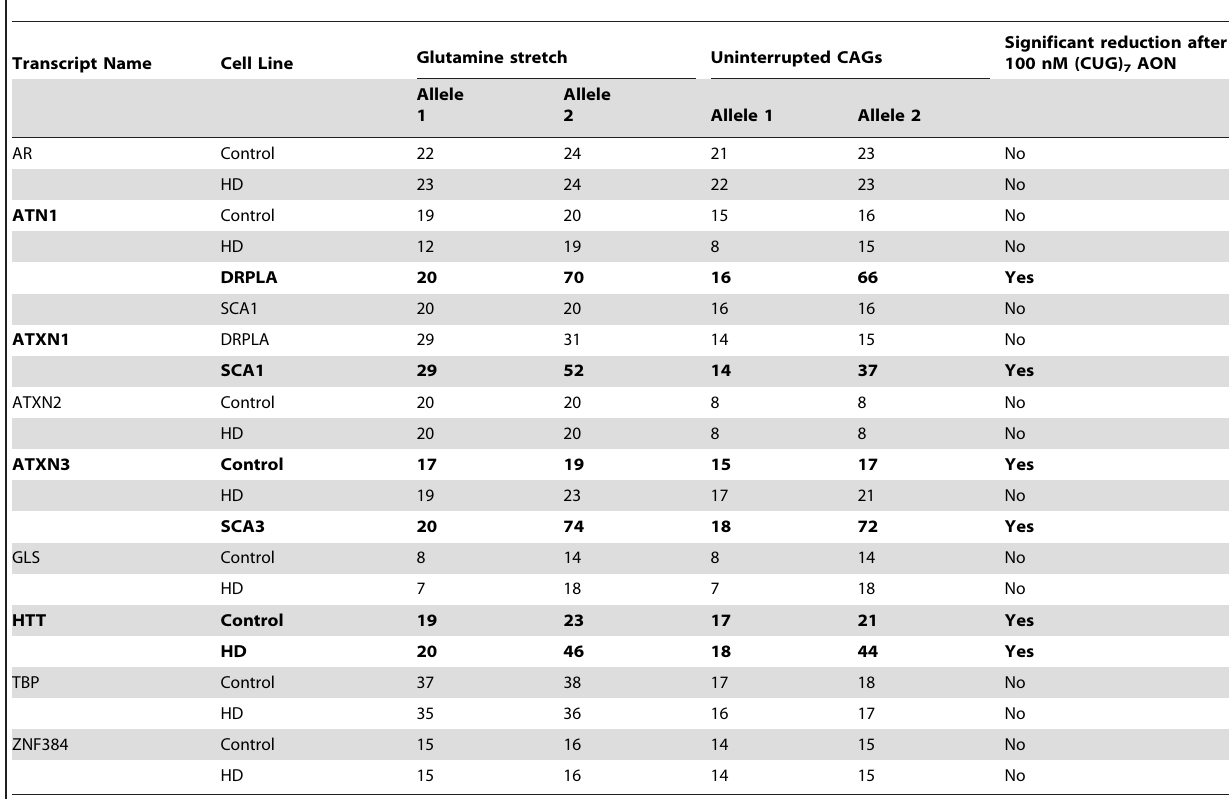
Table 1. Number of uninterrupted CAGs and codons that encode for glutamine in CAG repeat enclosing transcripts as determined by Sanger sequencing and a summary of the effect of (CUG) 7 treatment in those